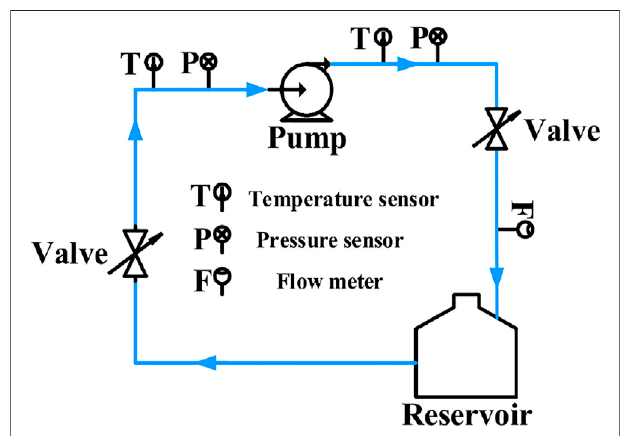
FIGURE 2 | Working fl uid pump performance test platform.